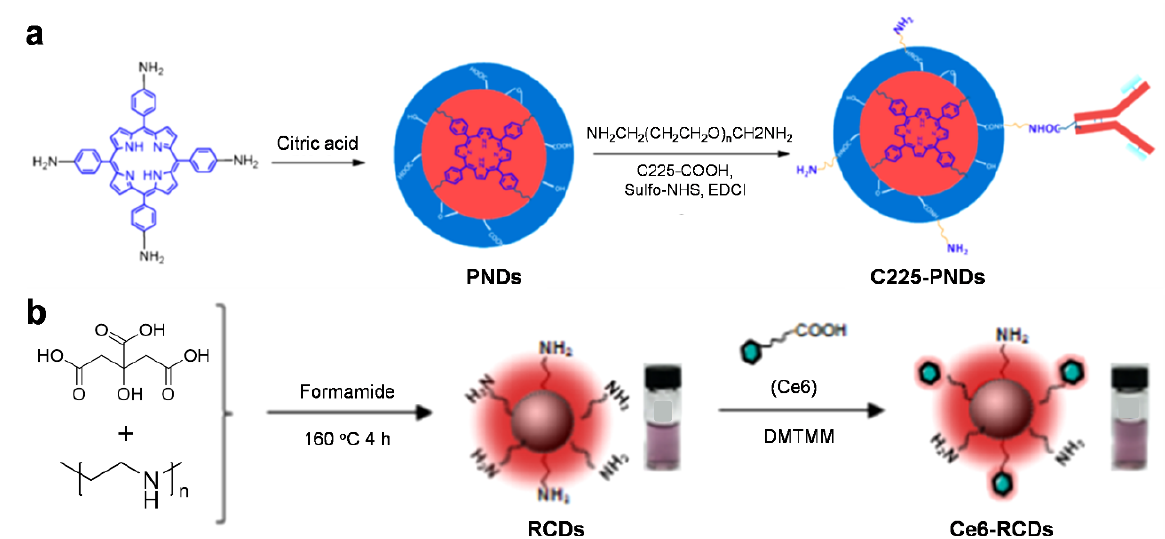
Figure 5. ( a ) Proposed formation pathway of PNDs and the synthesis routes of C225-PNDs. Reprinted with permission from [77]. Copyright, American Chemical Society (2018). ( b ) Schematic of the preparation of amino-rich red emissive carbon dots (RCDs) and Ce6-modified RCDs (Ce6-RCDs). Reprinted with permission from [78]. Copyright, American Chemical Society (2019).